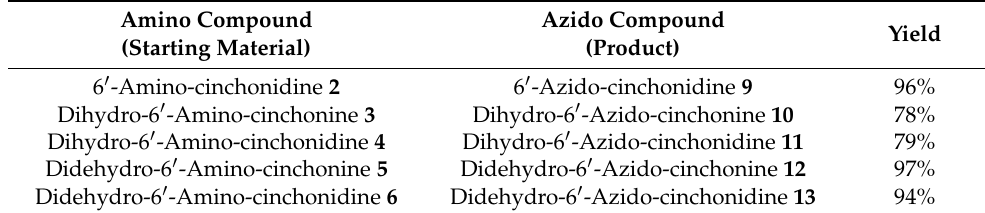
Table 1. Yields of the transformation of the amins 2 to 6 to the corresponding azides 9 to 13 . Amino Compound